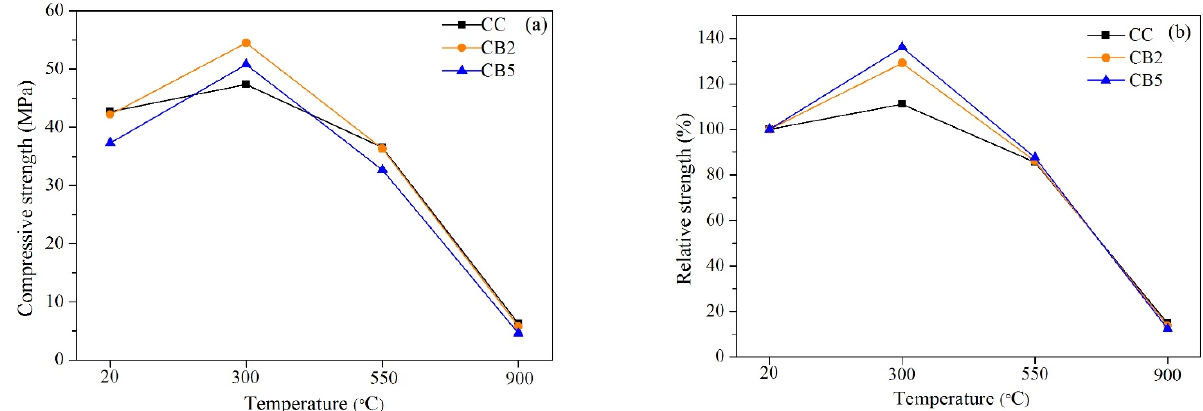
Figure 3. ( a ) Compressive strength of CC, CB2, and CB5 specimens at 20 °C and the residual compressive strength when exposed to 300, 550, and 900 °C. ( b ) Relative compressive strength of CC, CB2, and CB5 normalized to the strength at 20 °C.